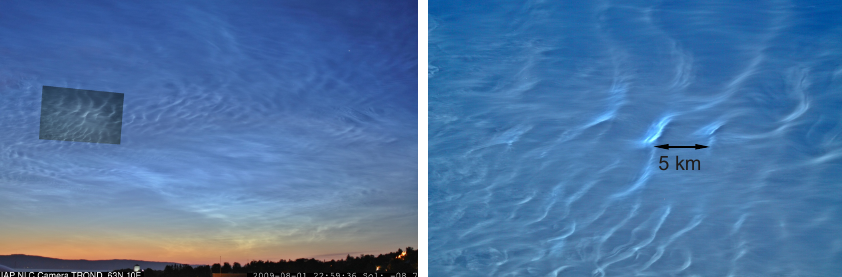
Fig. 1. Observation of a NLC from Trondheim (63.4 ◦ N) on 1 August 2009, 23:00UT. Left: using a camera with a wide field of view (47 ◦ × 31 ◦ ). Right: high-resolution image with a camera using a narrow FOV (marked by grey box in left picture). Structures are enhanced by a 2-stage local contrast filter (similar to Baumgarten et al., 2009). The horizontal dimensions of the high-resolution FOV are about 50km ×